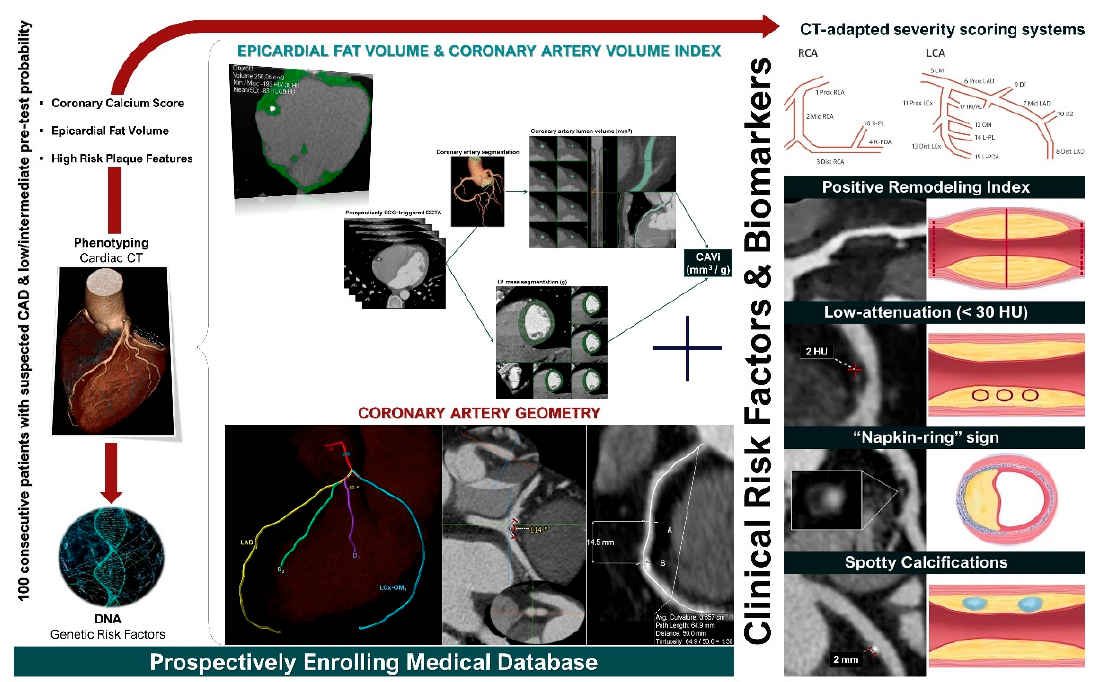
Diagnostics 2022 , 12 , x FOR PEER REVIEW Figure 2. GEOMETRY ‐ CTA study design (ClinicalTrials.gov ID: NCT04185493). Figure 2. GEOMETRY-CTA study design (ClinicalTrials.gov ID: NCT04185493).